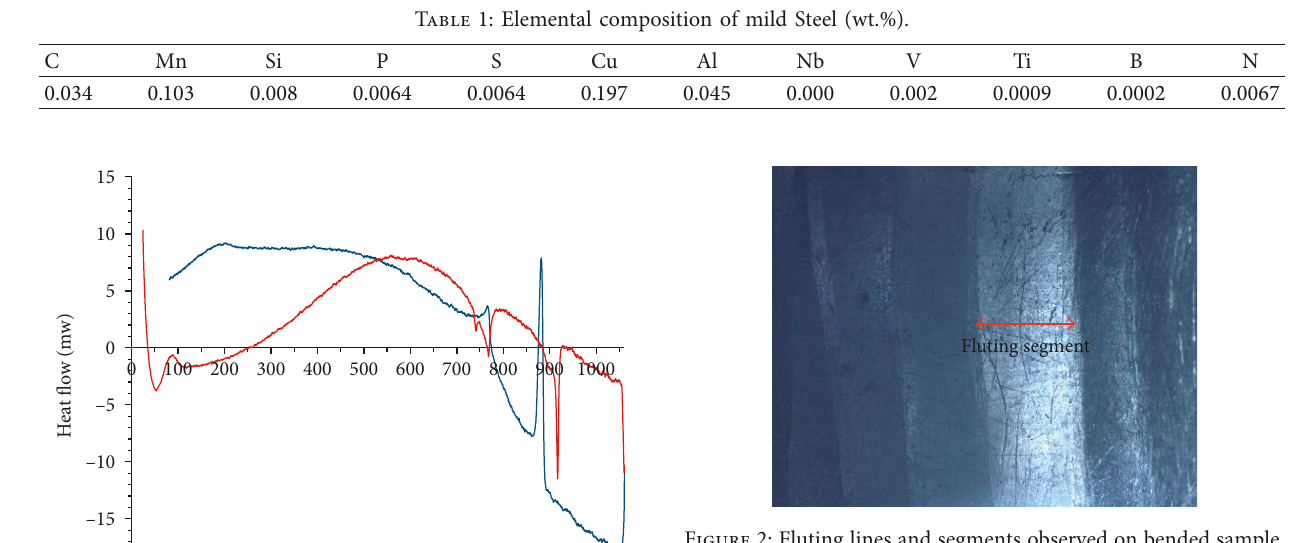
Figure 2: Fluting lines and segments observed on bended